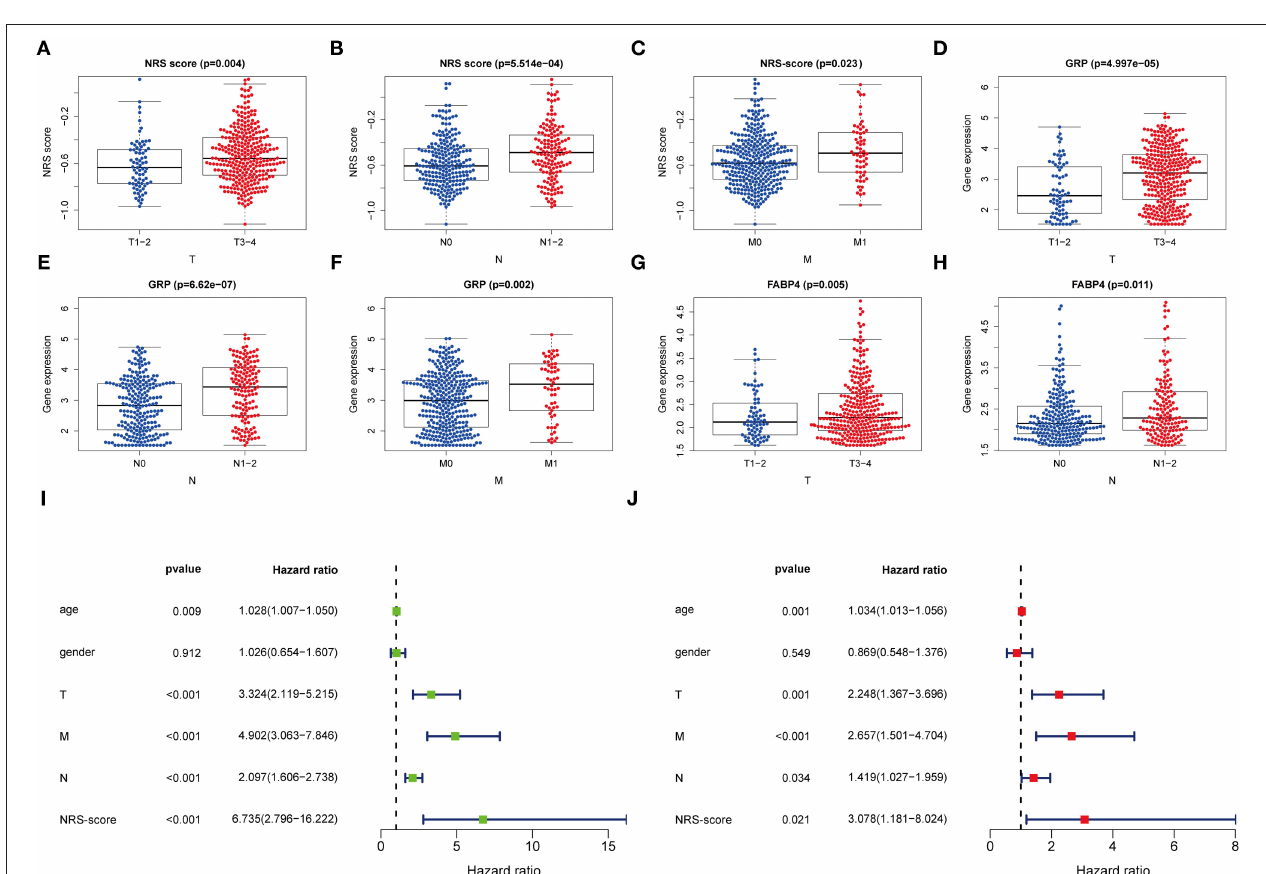
FIGURE 5 | Clinical application value and independent prognosis analysis. (A–C) Correlation between NRS-score and (A) T-stage, (B) N-stage, and (C) M-stage. (D–F) Correlation between GRP and (D) T-stage, (E) N-stage, and (F) M-stage. (G,H) Correlation between FABP4 and (G) T-stage, and (H) N-stage. (I) Univariate COX regression analysis based on NRS-score and clinical characteristics. (J) Multivariate COX regression analysis based on NRS-score and clinical characteristics.